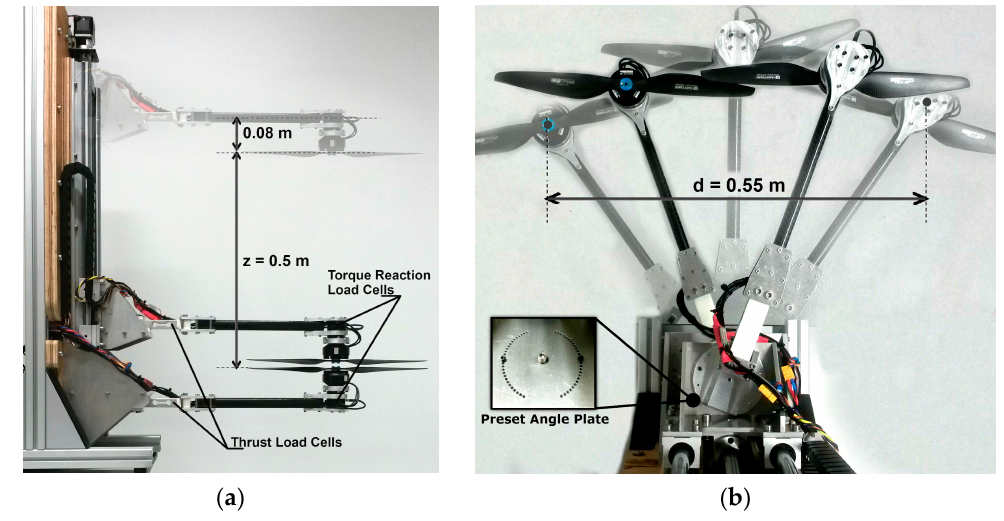
Figure 8. Overlapped rotor propulsion system test rig. ( a ) The test-rig side view shows maximum axial rotor separation; ( b ) The test-rig top view shows maximum rotor horizontal separation.